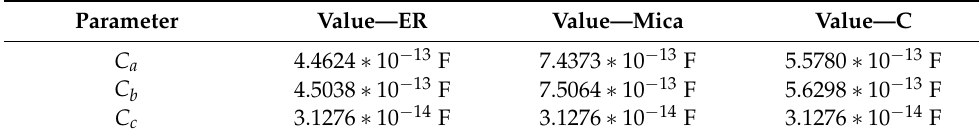
Table 4. Capacitive Model’s Parameters (2 h,